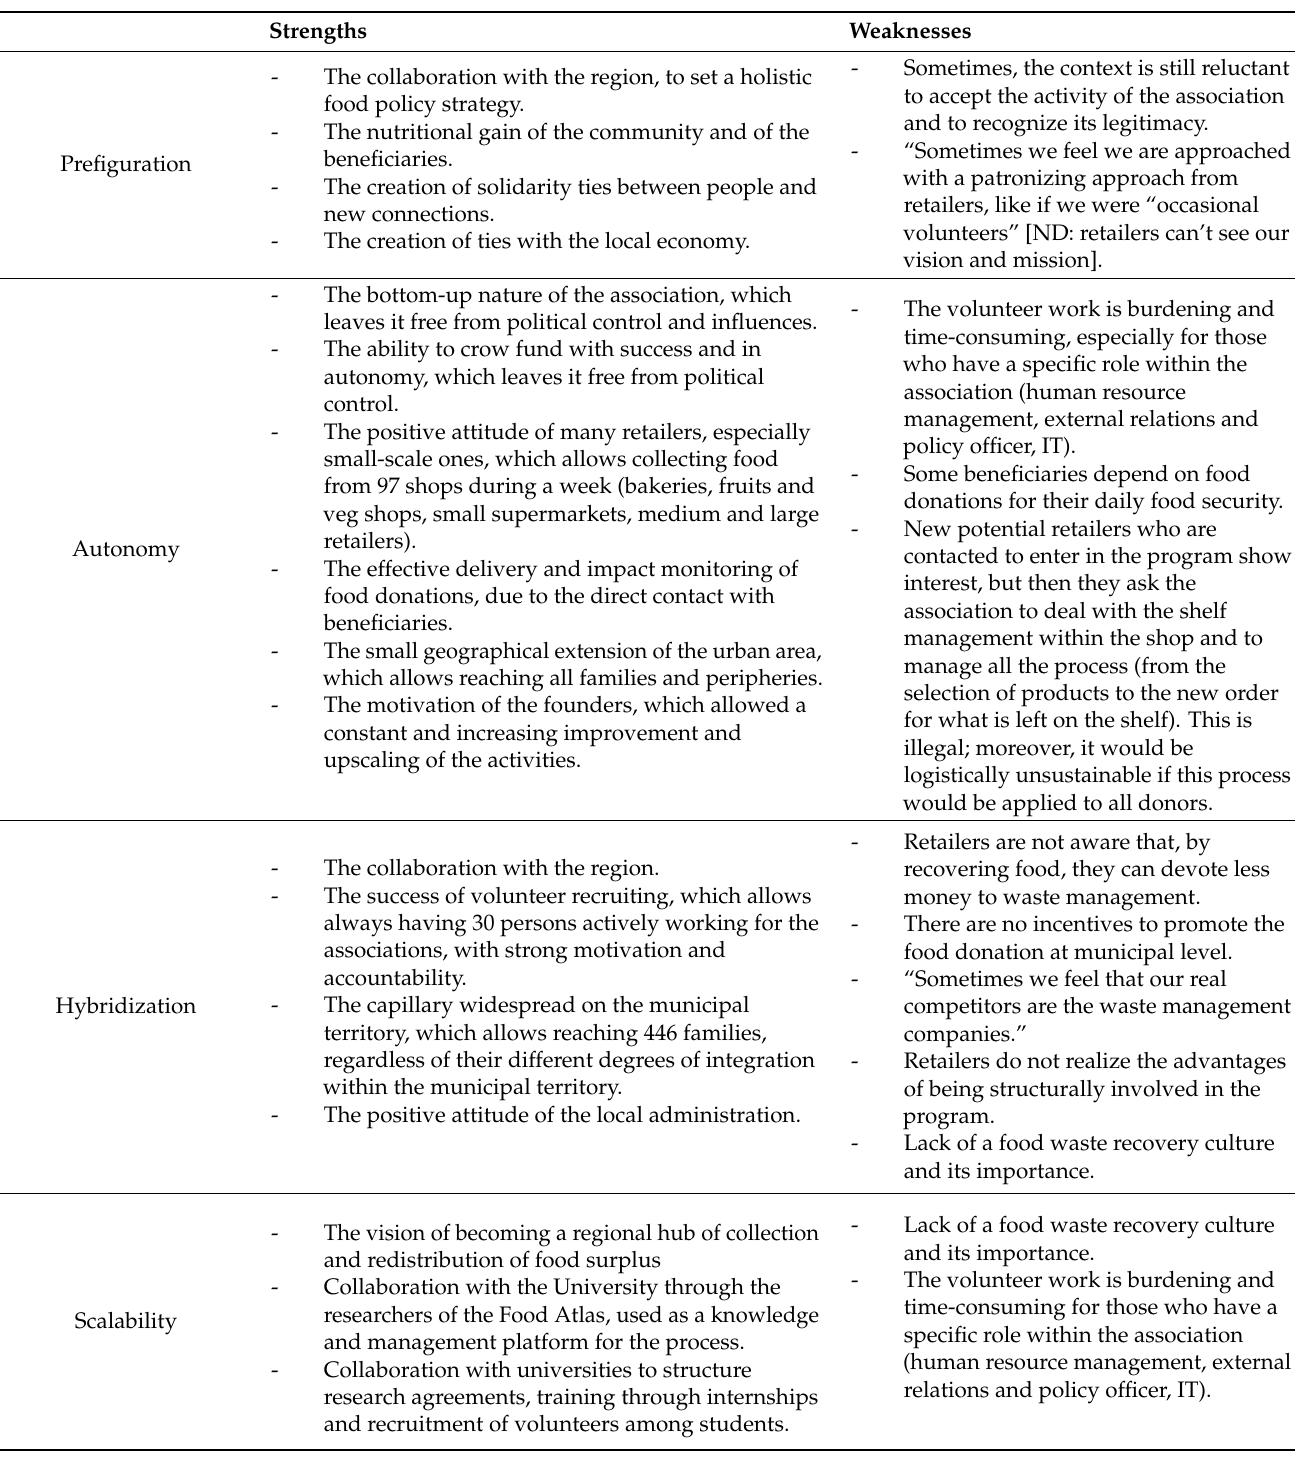
Table 1. Strengths and weaknesses of the project within the PAHS (prefiguration, autonomy, hybridization, and scalability) analytical